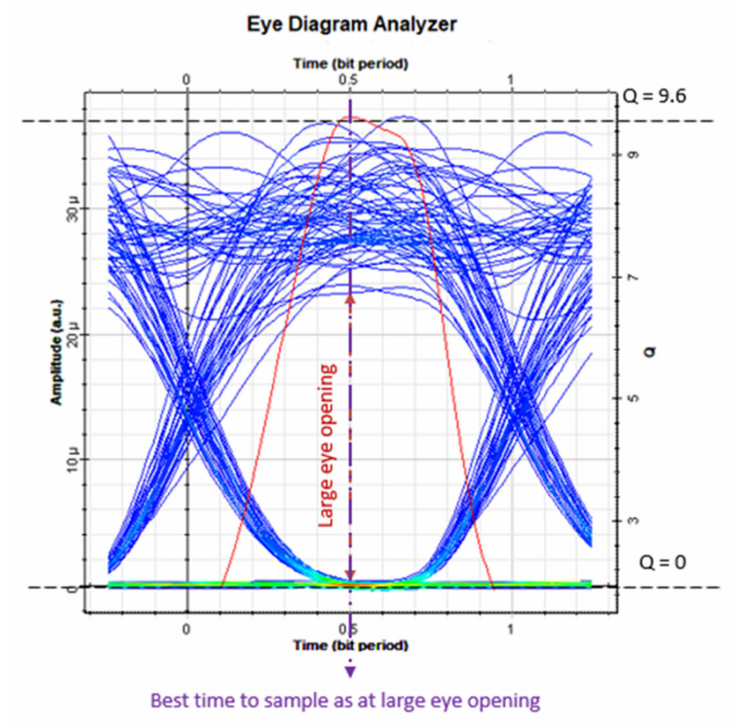
Figure 11. Example of Q-factor reading from eye diagram.